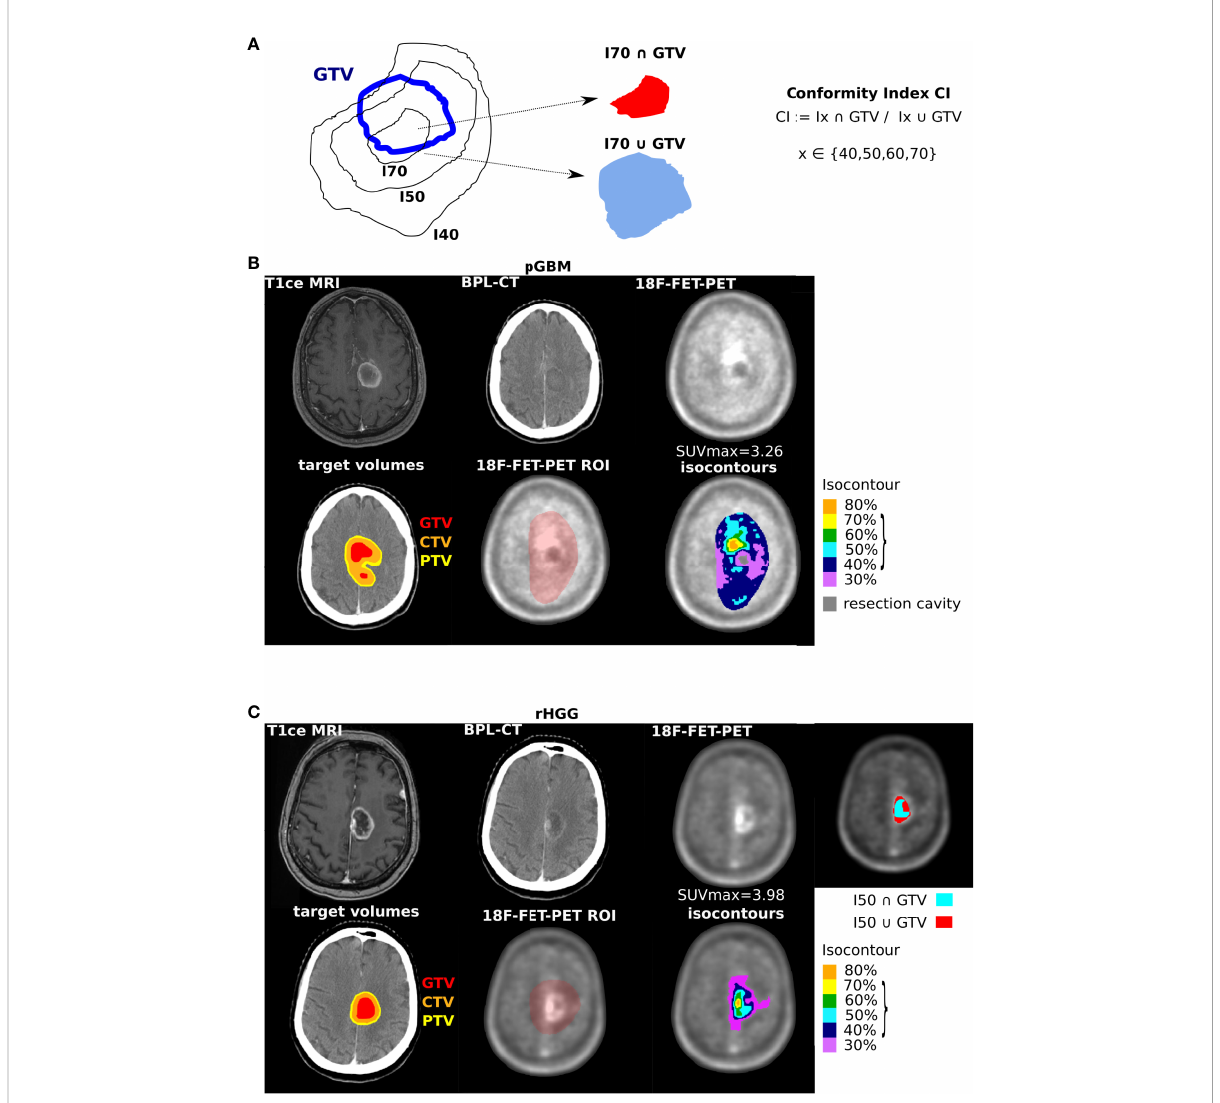
FIGURE 4 Concordance between 18 F-FET-PET de fi ned volumes and target volumes. (A) Schematics of evaluated volumes with isocontour I (I40%, 50%, and 70% shown as an example) and conformity index (CI) de fi nition. (B) Representative images with radiotherapy volumes and isocontours for a patient with primary glioblastoma, from left to right in the fi rst row: MRI at initial diagnosis, planning CT, 18 F-FET-PET imaging before radiotherapy; in the second row: planning CT with MRI-based tumor volumes (GTV in red, CTV in orange, and PTV in yellow), de fi ned region of interest (ROI) in 18 F-FET-PET imaging, and 18 F-FET-PET-based isocontours (30% in purple, 40% in blue, 50% in turquoise, 60% in green, 70% in yellow, and 80% in orange). (C) Representative images with radiotherapy volumes and isocontours for a patient with recurrent high-grade glioma, imaging, and color coding similar to panel (B) Additional illustration of a representative image for I50 and GTV with intersection of volumes shown in turquoise and union of volumes shown in red. Parentheses, values further evaluated; see Figure 5. GTV, gross tumor volume; CTV, clinical target volume; PTV, planning target